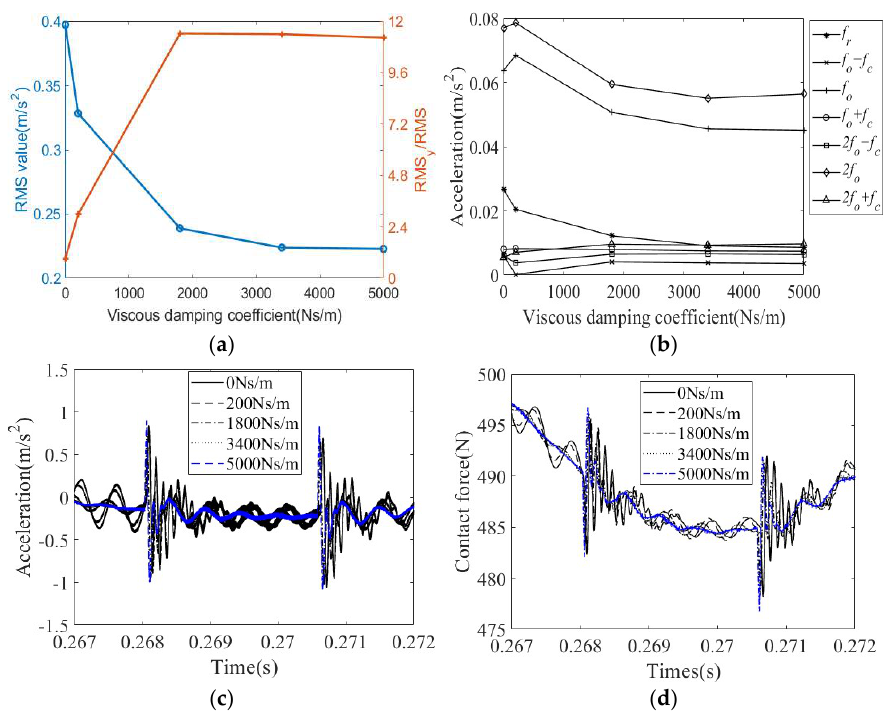
Figure 19. The vibration characteristics of the bearing under outer ring defect and viscous damping: ( a ) RMS and RMS y /RMS; ( b ) amplitudes of f r , f o − f c , f o , f o + f c , 2 f o − f c , 2 f o , 2 f o + f c ; ( c ) housing acceleration signal from 0.267 s to 0.272 s; ( d ) contact force between outer ring and housing from 0.267 s to 0.272 s.